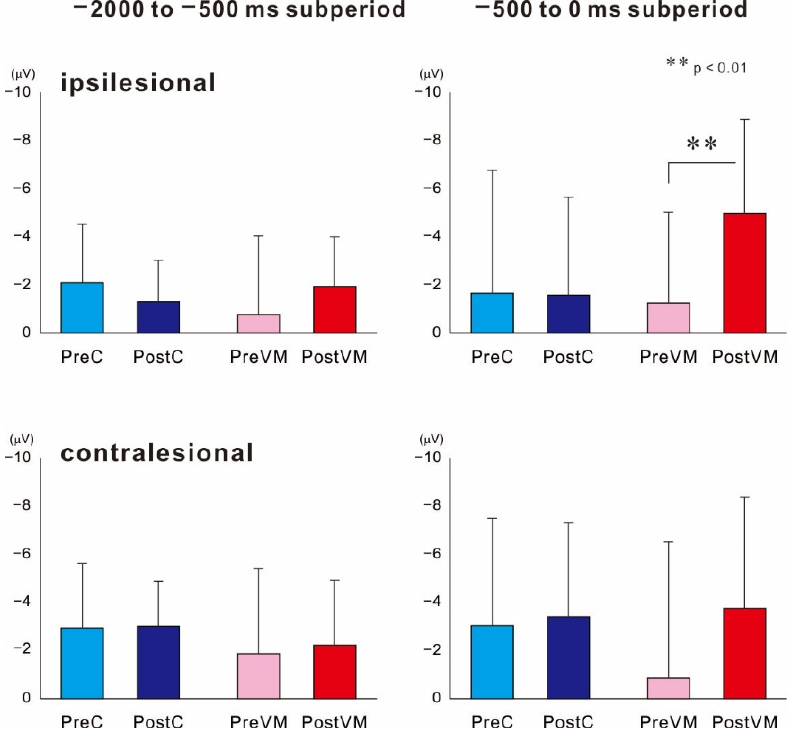
Figure 3. Mean amplitudes of MRCPs recorded within − 2000 to − 500 ms and − 500 to 0 ms subperiods from ipsilesional and contralesional motor cortices before (Pre) and after (Post) the motor intervention (C or VM). In the damaged hemisphere, mean MRCP amplitude after the VM task (Post-VM) was significantly enhanced during the − 500 to 0 ms subperiod but not during the − 2000 to − 500 ms subperiod. There were no changes in MRCP amplitudes during either subperiod after the control intervention. ** p < 0.01, statistical significance compared within two pairs.